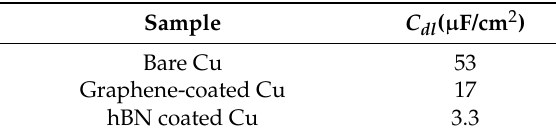
Table 3. Measurement of C dl for 2D material coated Cu in 0.1 M NaCl solution. Adapted under